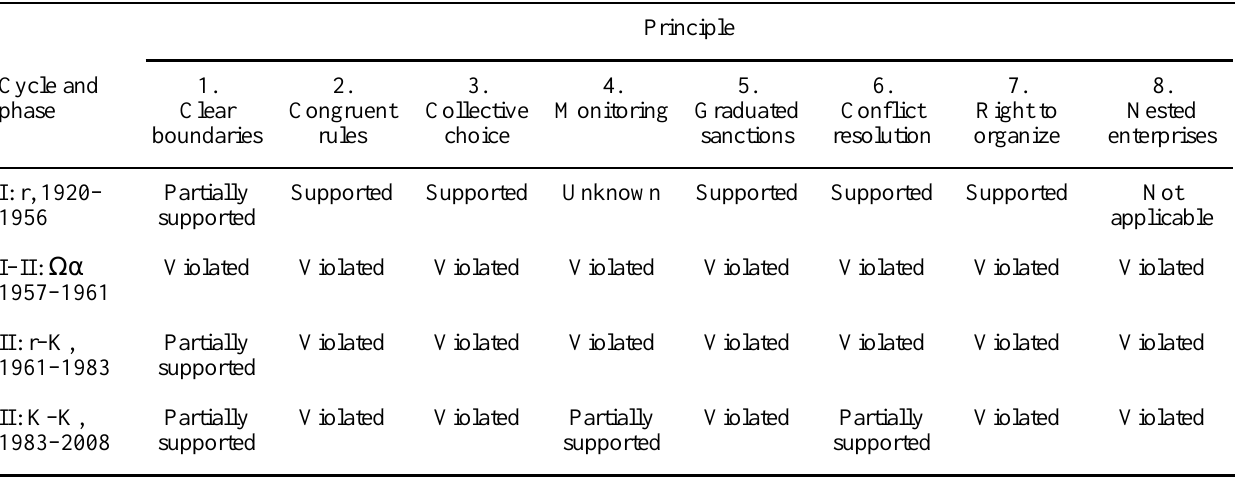
Table 2. Qualitatve assessment of adherence to Ostrom’s (1990) eight design principles, based on oral interviews and field